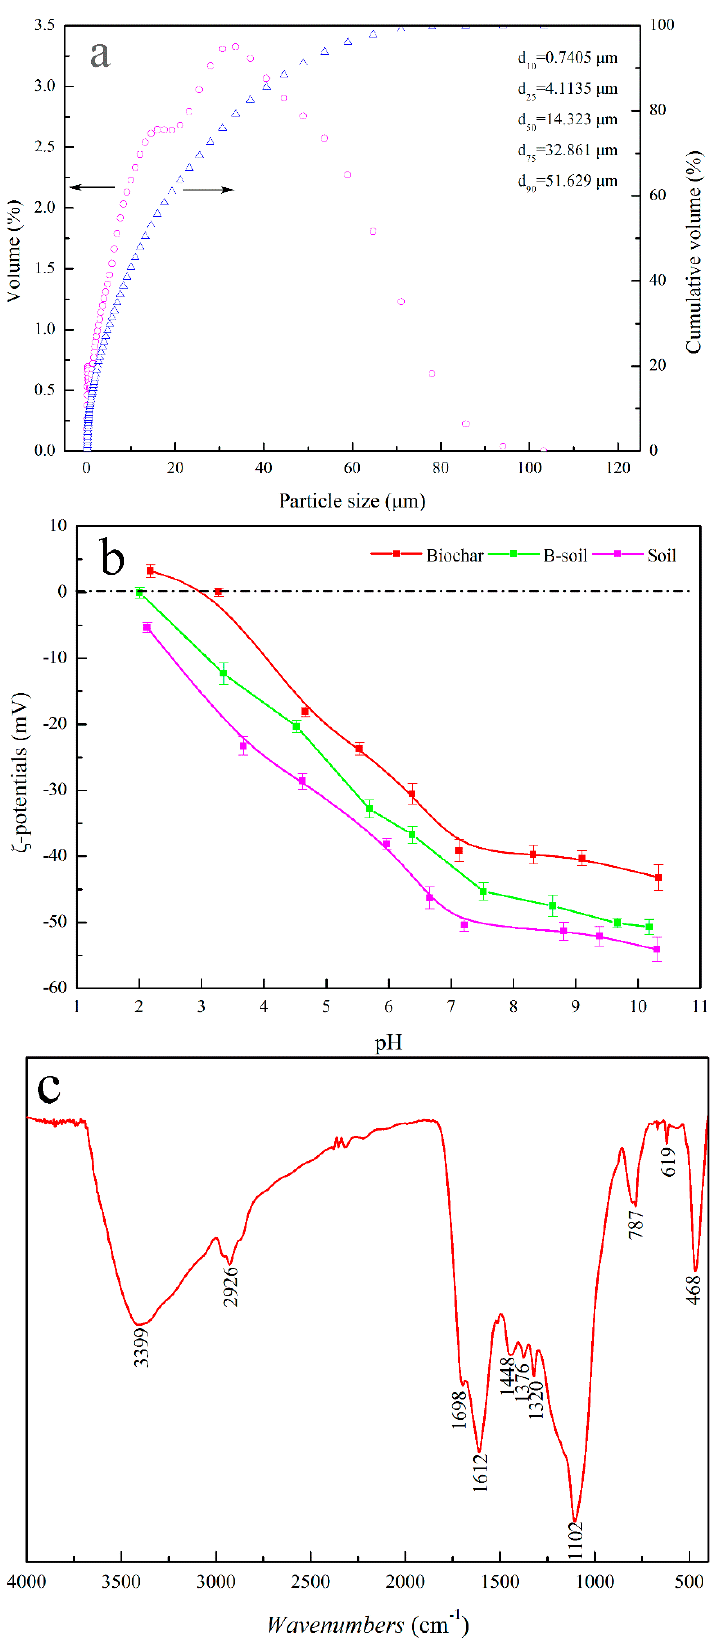
Figure 1. Particle size distribution of the soil sample ( a ), Zeta-potentials of the biochar and soil B-soil samples ( b ), and FT-IR spectra of the biochar sample ( c ).